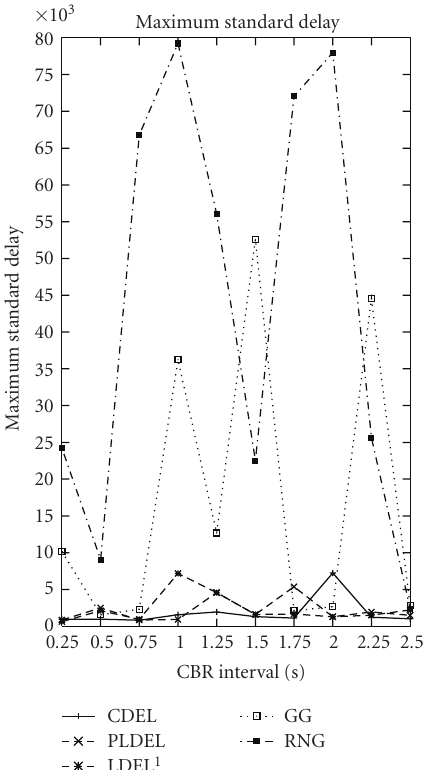
Figure 16: Maximum standard delay in μ sec.